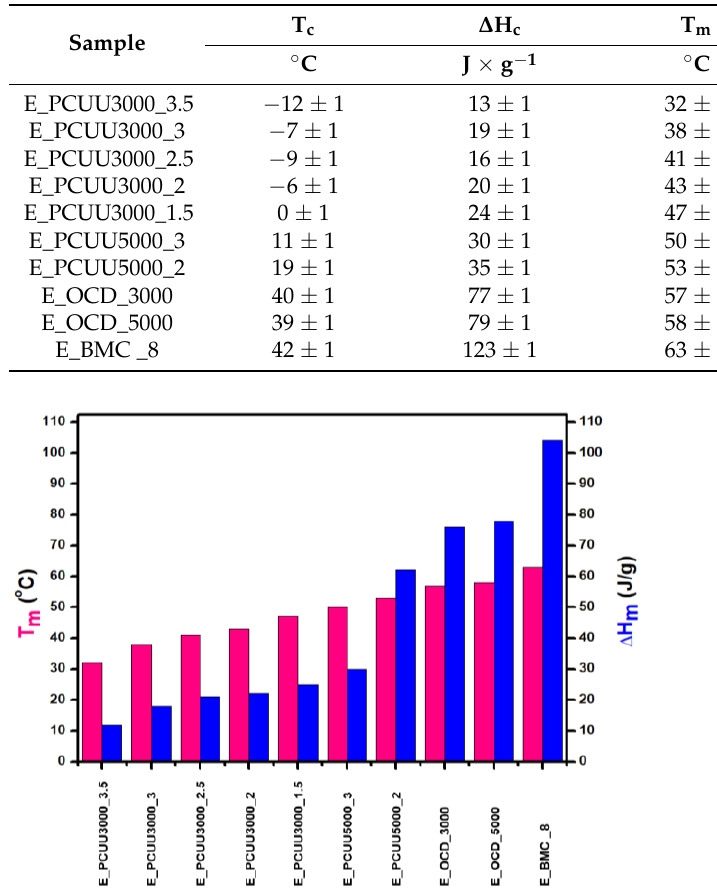
Figure 8. Thermal properties determined based on DSC measurements of PCUUs, OCDs, and BMC: melting points T m (pink color) and melting enthalpies ΔH m (blue color). Table 3. Thermal properties determined based on DSC measurements of PCUUs, OCDs, and BMC.